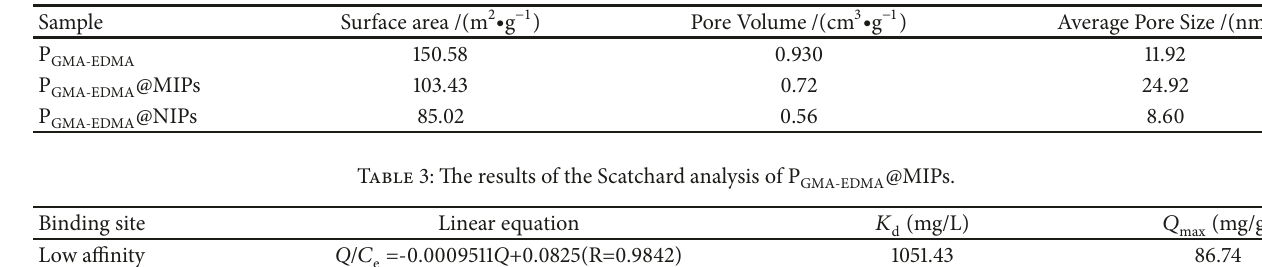
Table 2: Comparison of P GMA